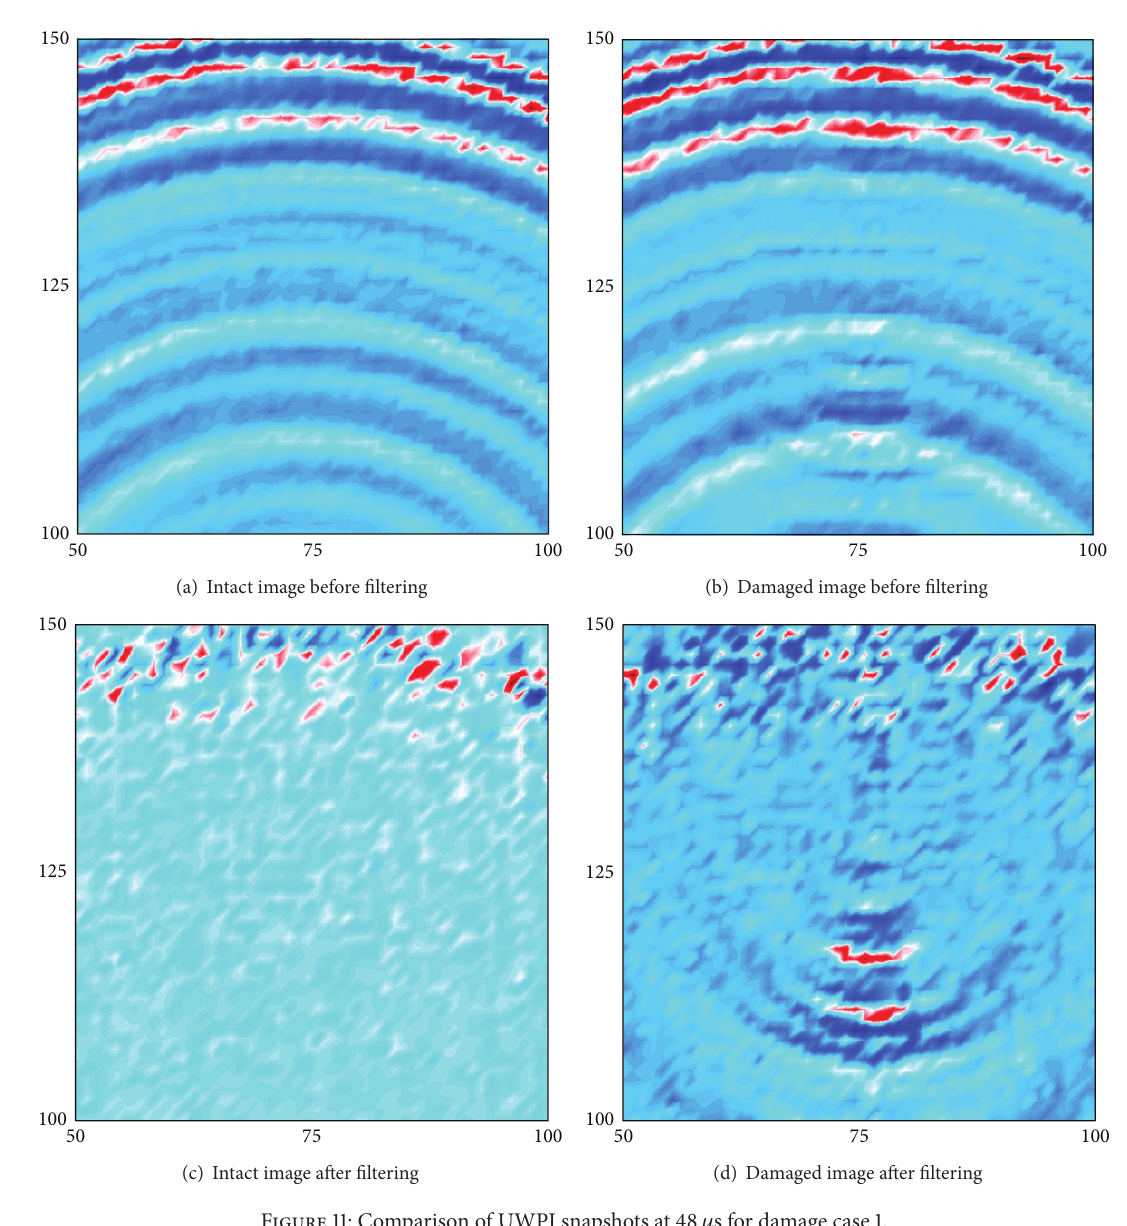
Figure 11: Comparison of UWPI snapshots at 48 𝜇 s for damage case